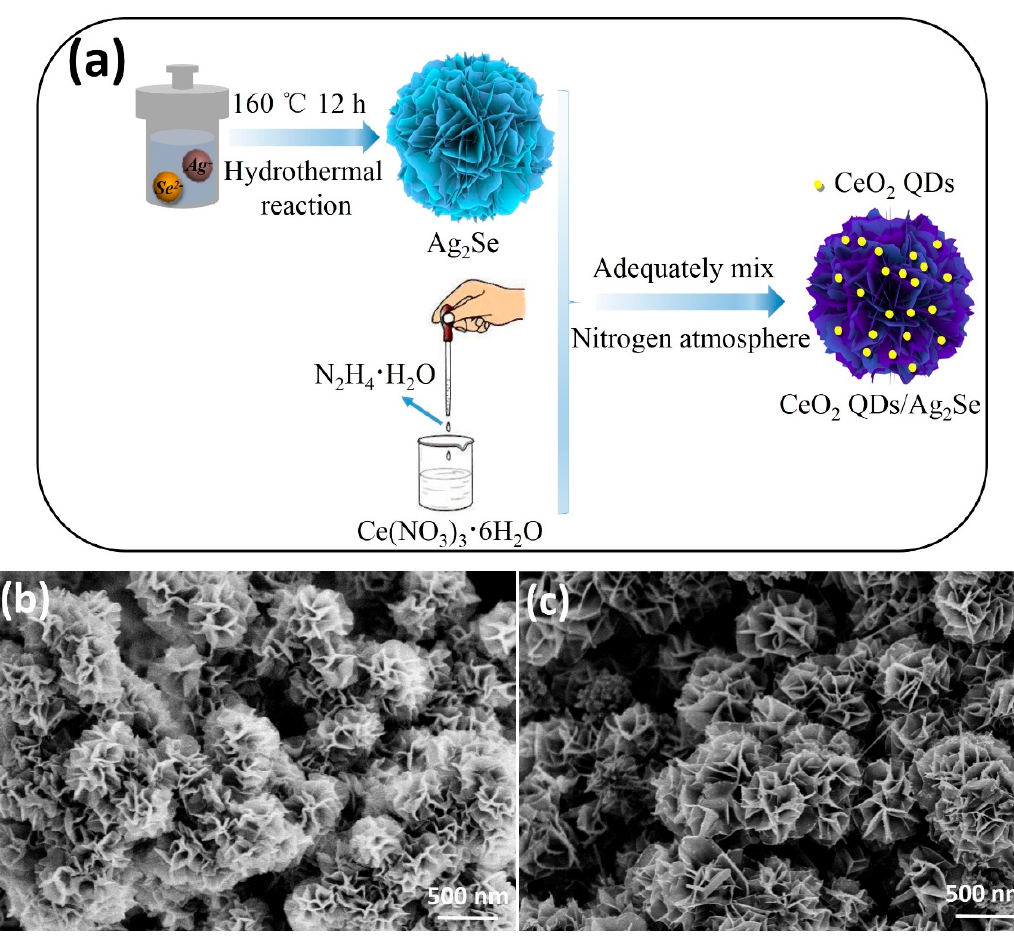
Figure 3. ( a ) Schematic diagram of CeO 2 QDs/Ag 2 Se Z-scheme nano-heterojunction synthesis. SEM images of ( b ) Ag 2 Se nanoflowers and ( c ) 10% CeO 2 QDs/Ag 2 Se.